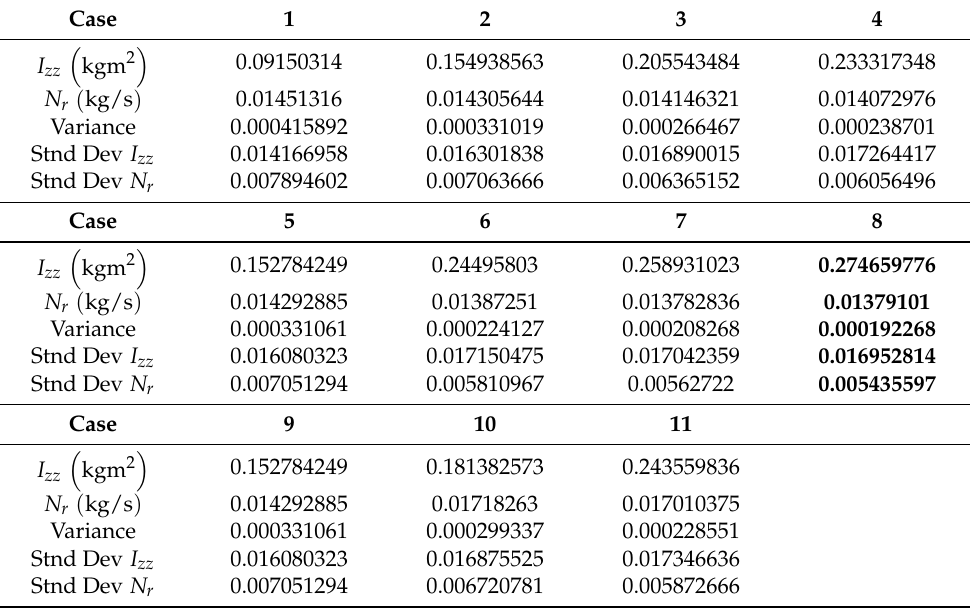
Table A6. Results of the estimation of hydrodynamic parameters for the motion in ψ with 150